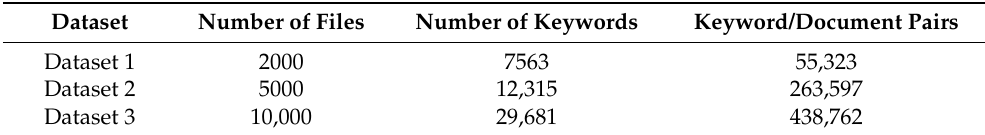
Table 4. Test data table.